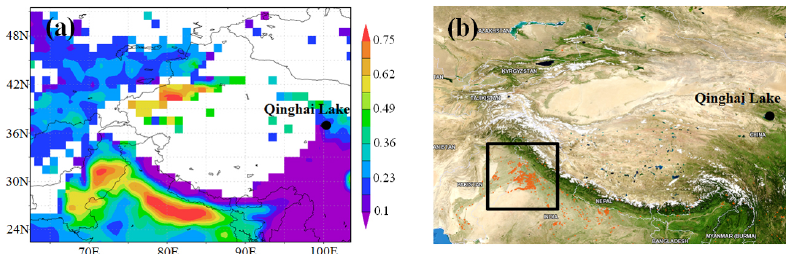
Figure 5. Regional distributions of (a) aerosol optical depth (AOD) and (b) fire counts map over the Qinghai–Tibetan Plateau derived from MODIS observations during 16–27 November